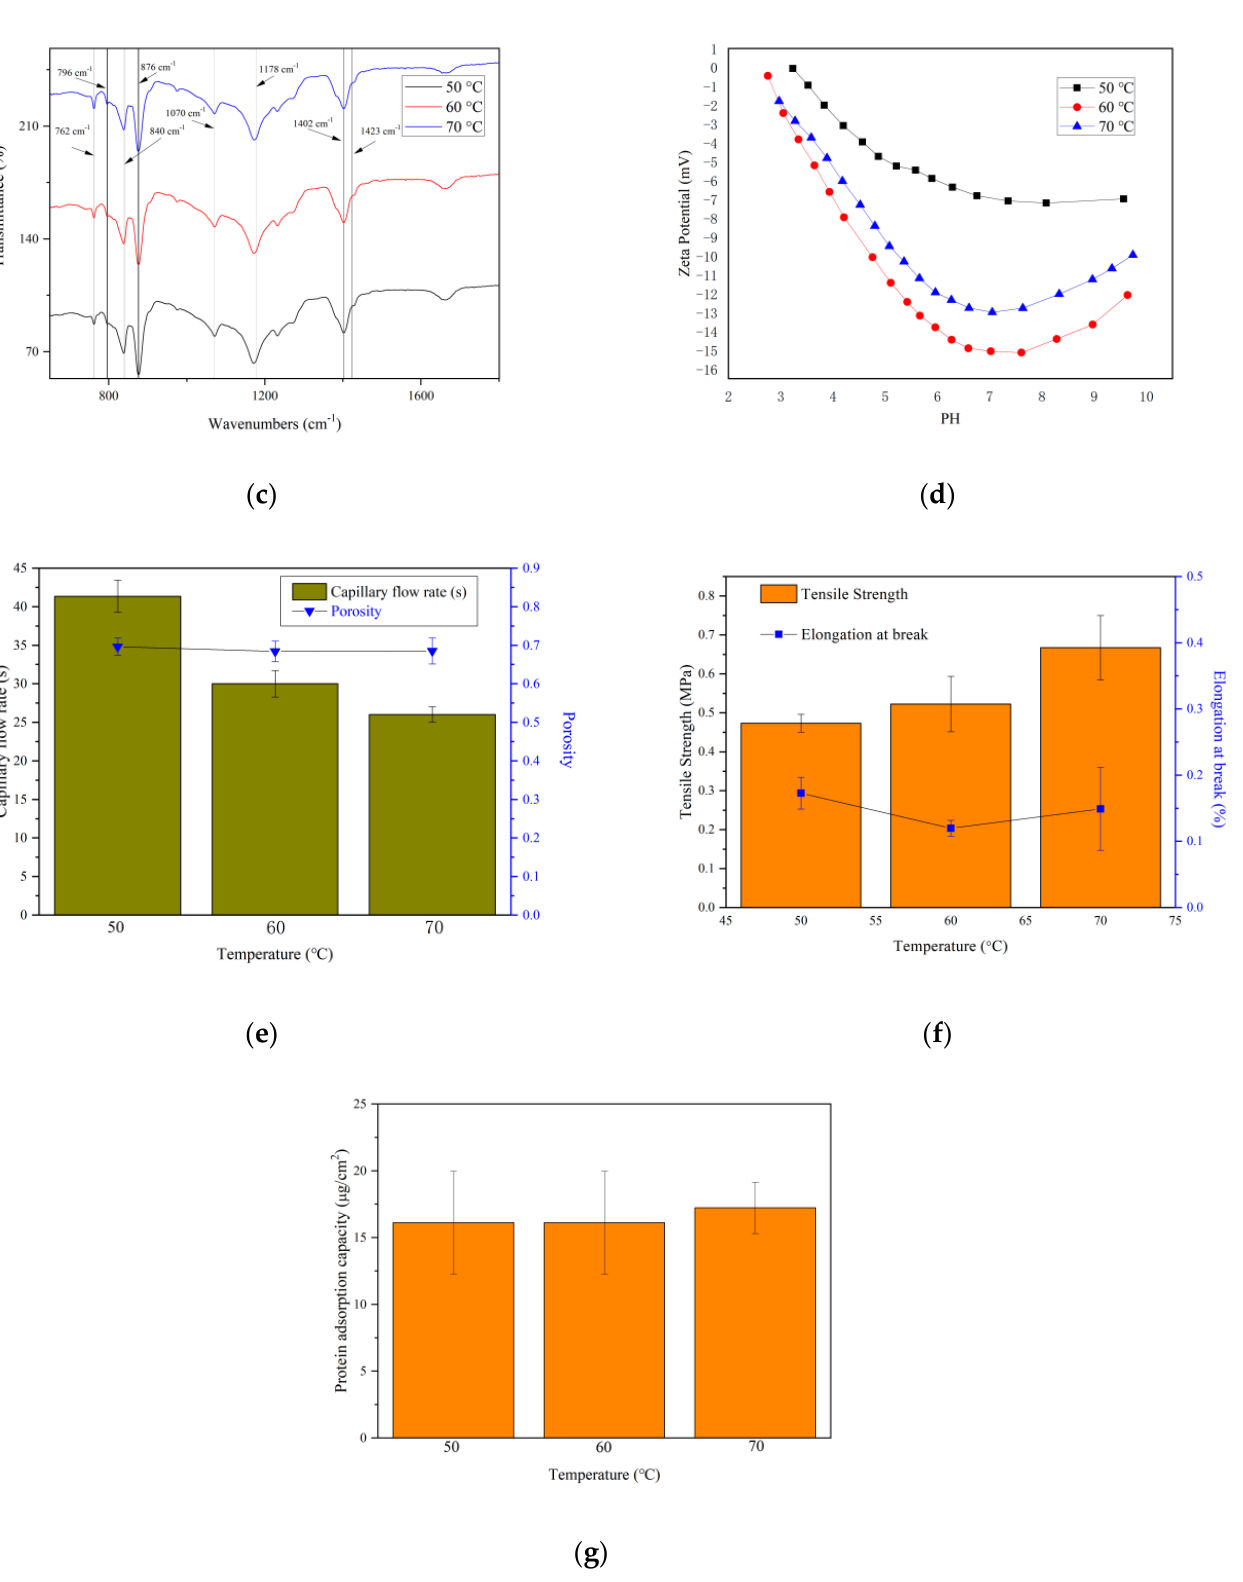
Figure 7. ( a ) Pore size distribution, ( b ) XRD spectra, ( c ) FT-IR spectrum, ( d ) zeta potential, ( e ) capillary flow rate and porosity, ( f ) tensile strength and elongation at break and ( g ) protein adsorption capacity of PVDF membranes prepared at different vapor temperatures.